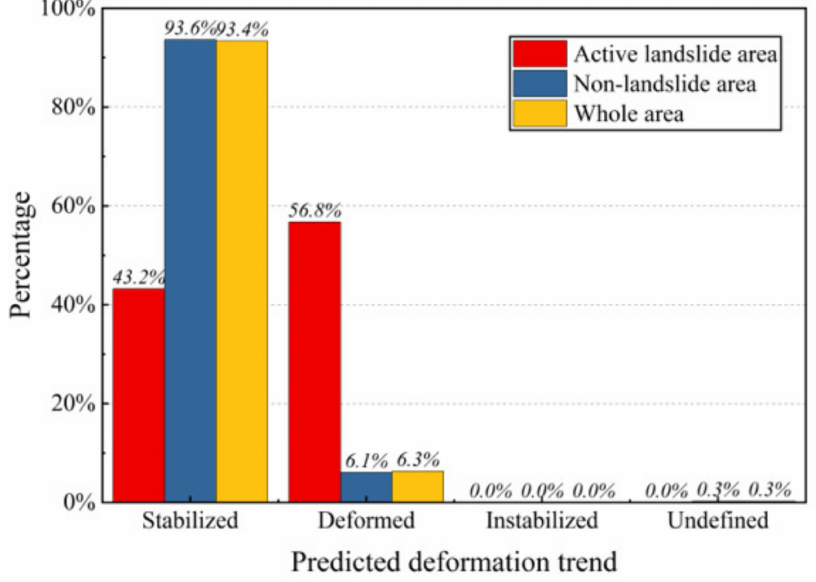
Figure 11. Statistics of predicted deformation trends in active landslide and non-landslide